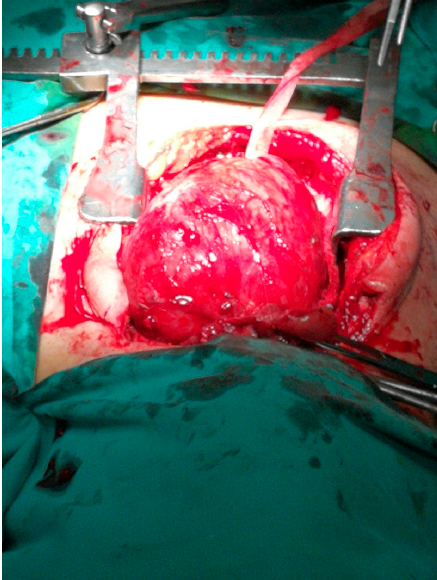
Figure 4. The mobilization of the substernal goiter through the cervical incision and partial ster- notomy (cervico-sternotomy).